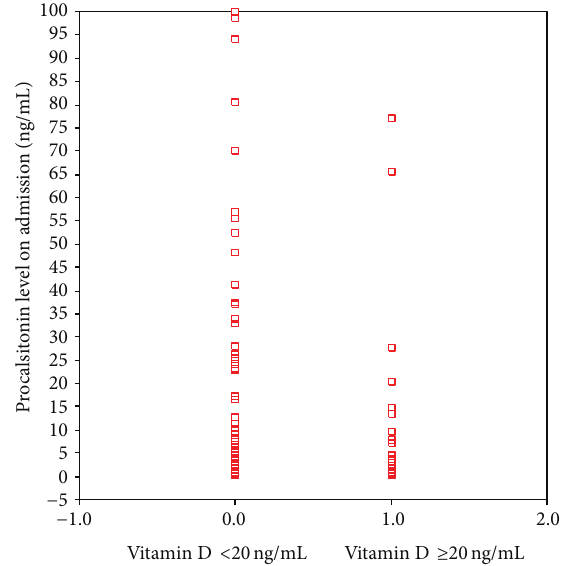
Figure5:ProcalsitoninlevelsofvitaminDsufficientandinsufficient groups (𝑃 = 0.044) .